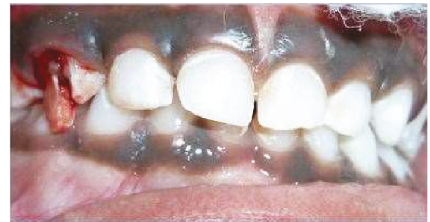
Figure 1: Preoperative photograph depicts fractured 53.